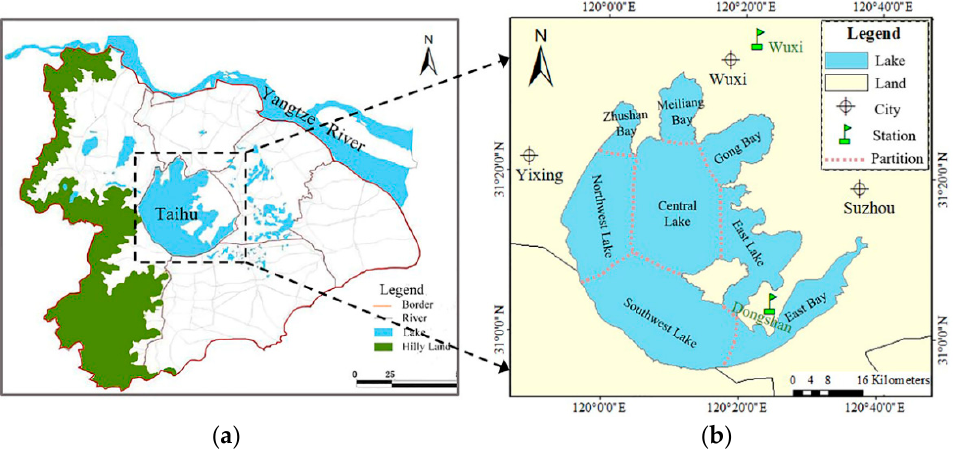
Figure 1. ( a ) Location of Taihu Lake in China. ( b ) Map of the study